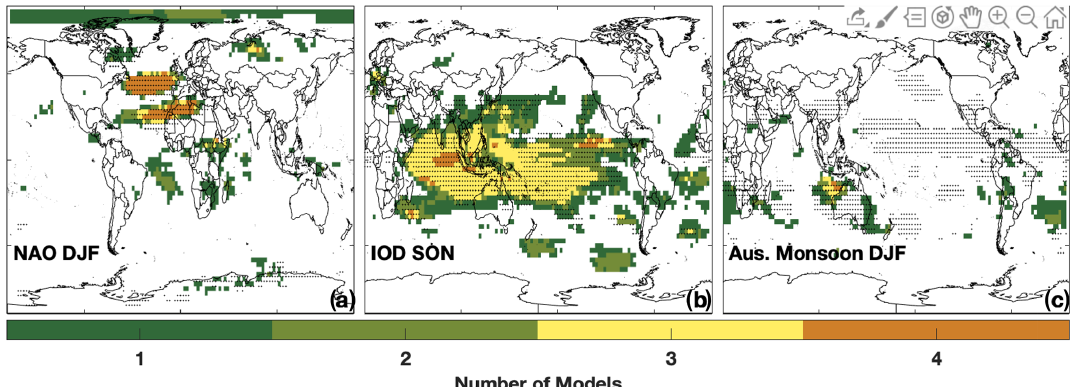
Figure 21. Same as Fig. 19 except for the NAO (a) , the IOD (b) , and the Australian Monsoon (c) . The NAO and Australian monsoon are shown for DJF and the IOD for